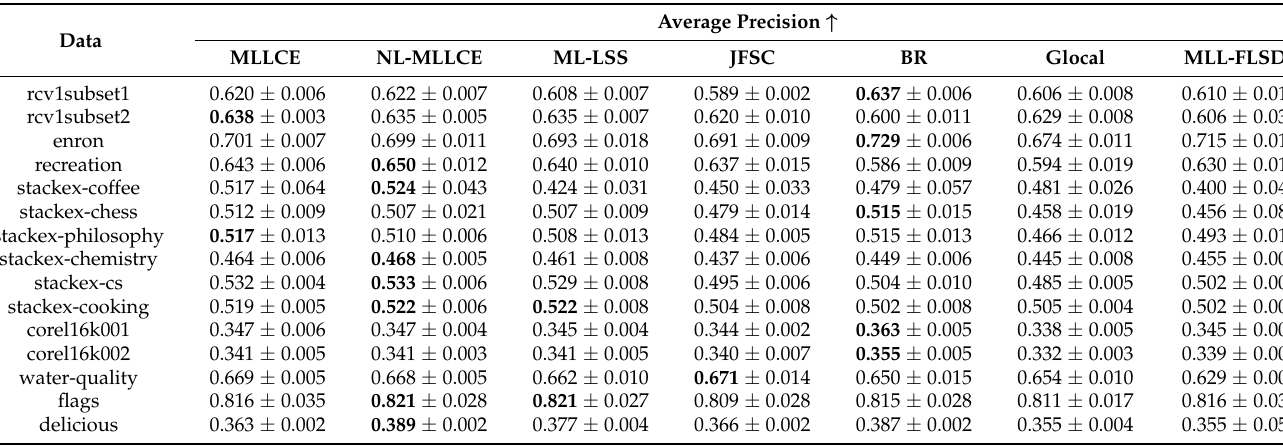
Table 3. The experimental results (mean ± standard) of all comparison methods in this paper in terms of Average Precision. ↑ means that the larger the value, the better the performance is. The best results in each row are highlighted in bold face. Average Precision ↑ Data MLLCE